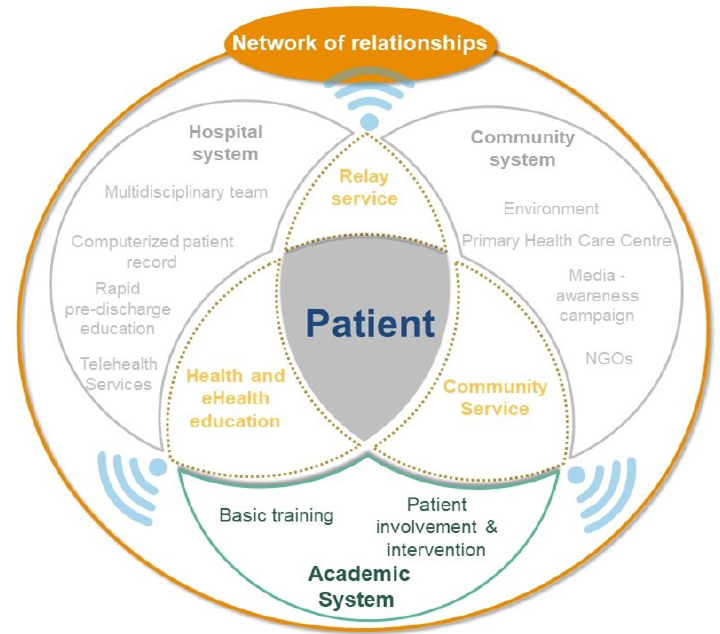
Figure 5. Academic